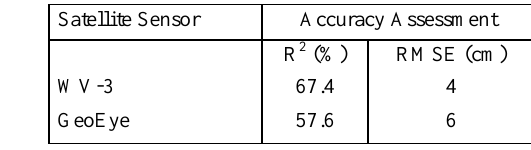
Table 1. Accuracy statistics of the OBRA for the best pair of spectral